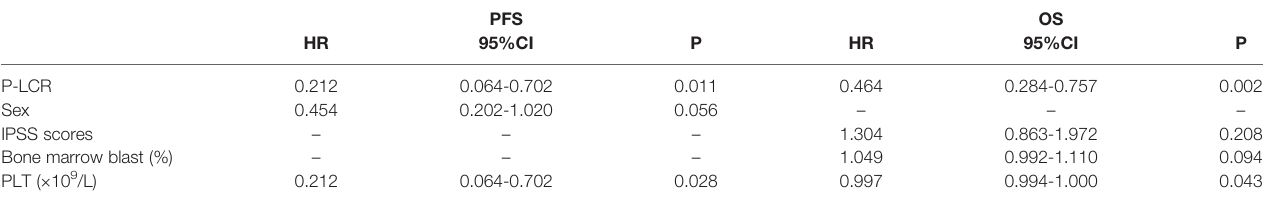
TABLE 3 | Multivariate analyses for PFS and OS in 122 MDS patients in relation to prognostic